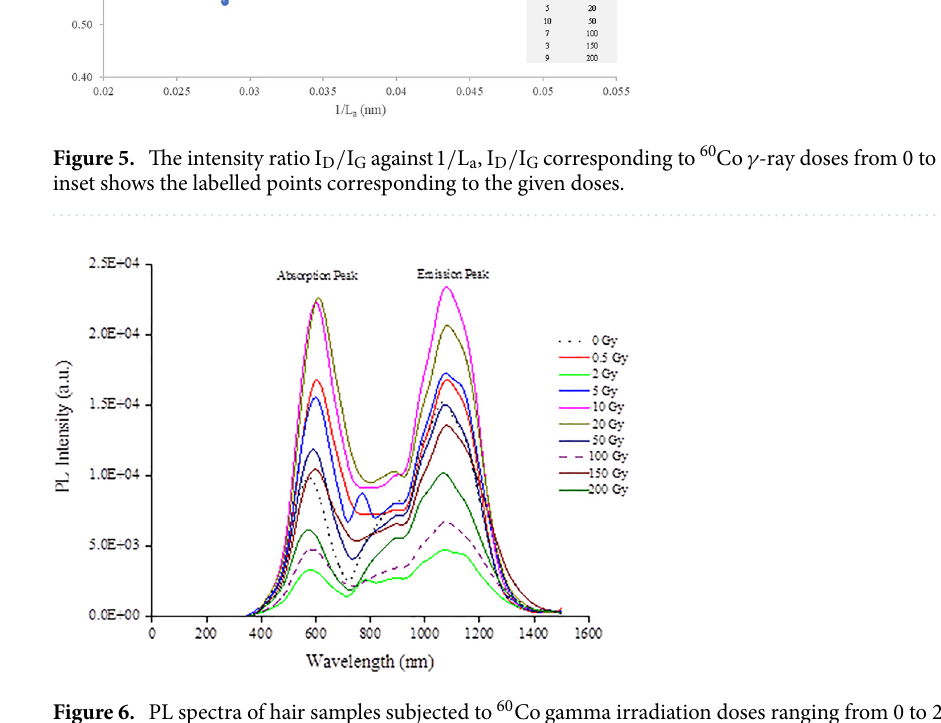
Figure 6. PL spectra of hair samples subjected to